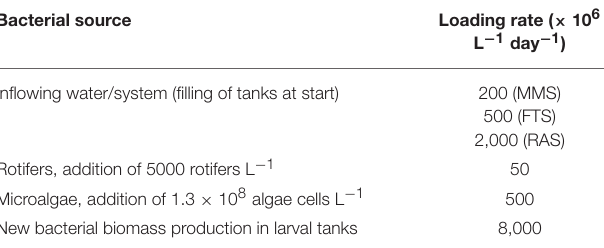
TABLE 2 | First day supply of bacteria following addition of water and live food for an initial stocking density of 100 larvae L − 1